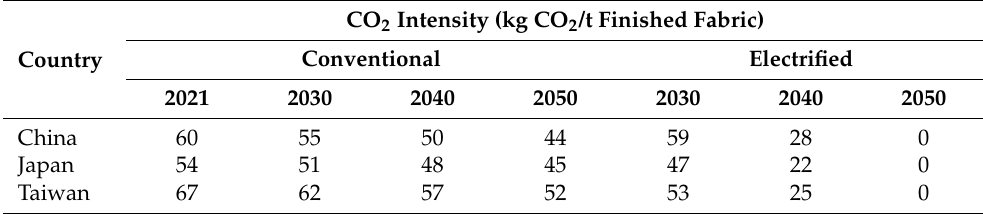
Table 15. The CO 2 intensity of the conventional and electrified yarn drying process. CO 2 Intensity (kg CO 2 /t Finished Fabric) Conventional Electrified Country 2021 2030 2040 2050 2030 2040 2050 China 60 55 50 0 Japan 54 Taiwan